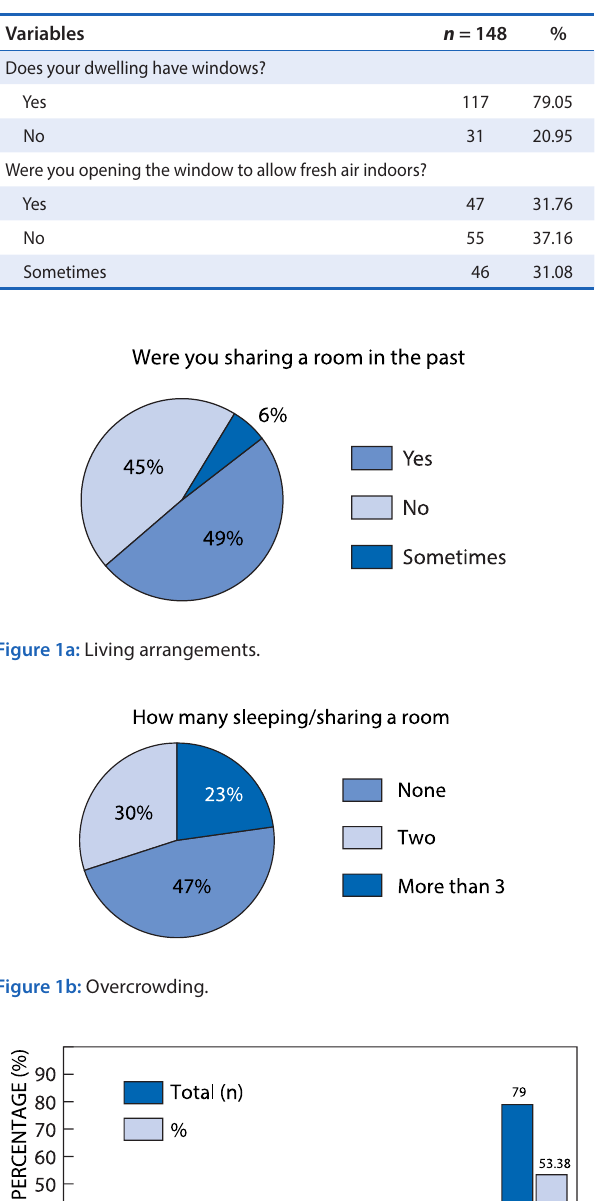
Table 3: Environmental factors: indoor ventilation.